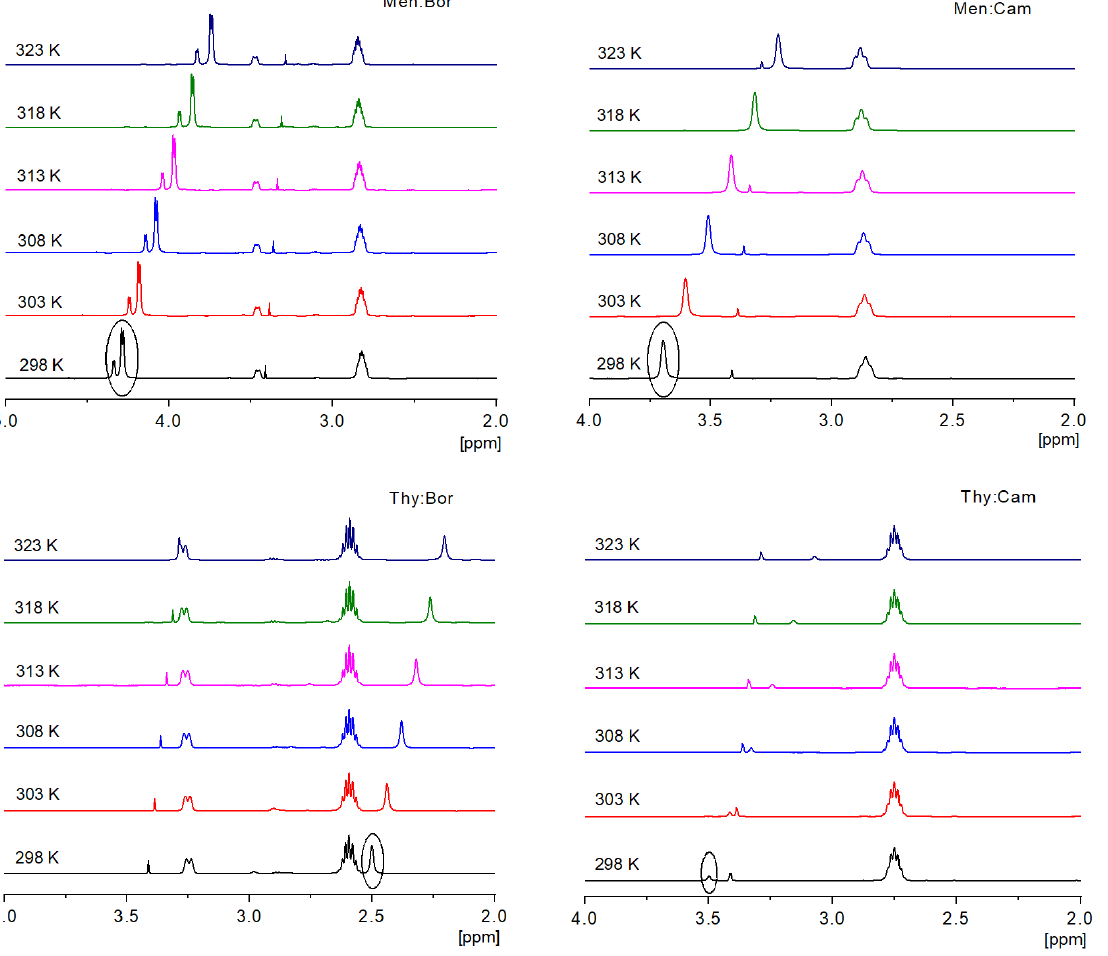
Figure 2. Magnified 1 H-NMR spectra of the eutectic systems as a function of temperature.